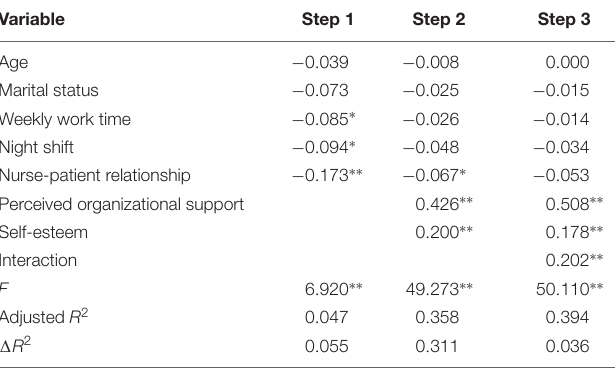
TABLE 3 | Hierarchical multiple regression results of SWB.